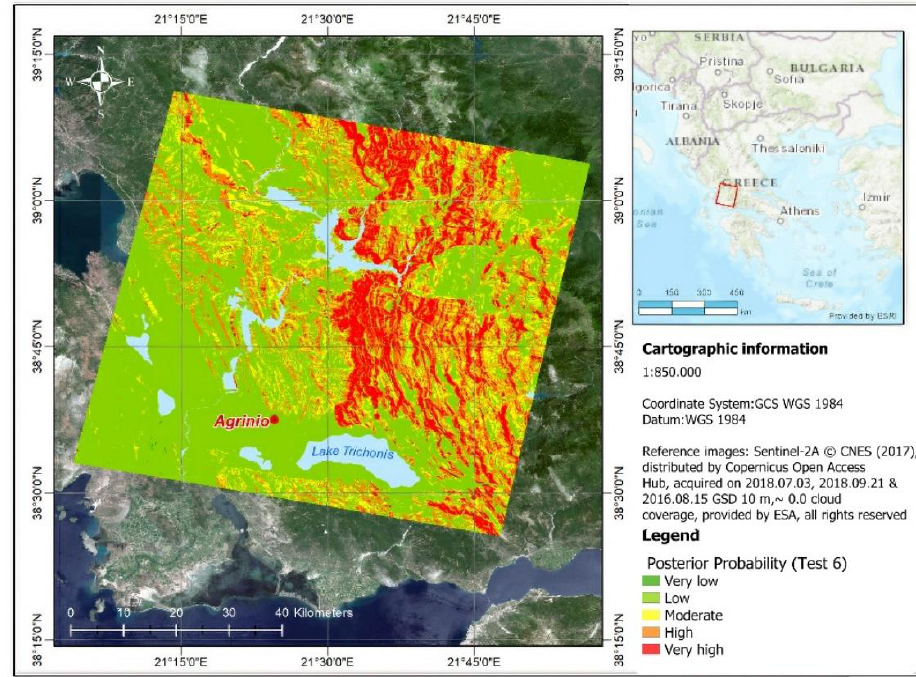
Figure 11. Landslide susceptibility map derived from test 1 and test 6 iterations.